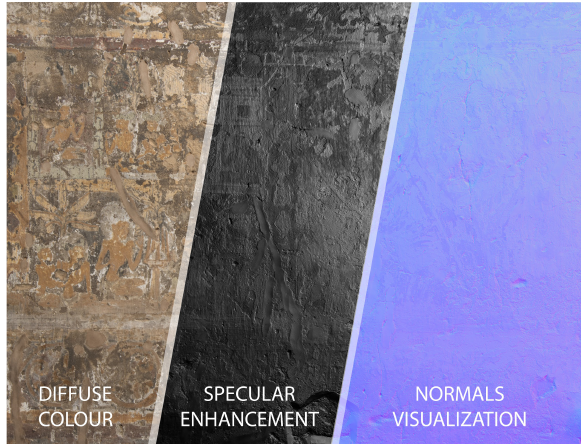
Figure 5. Myin-pya-gu wall painting RTI data set.